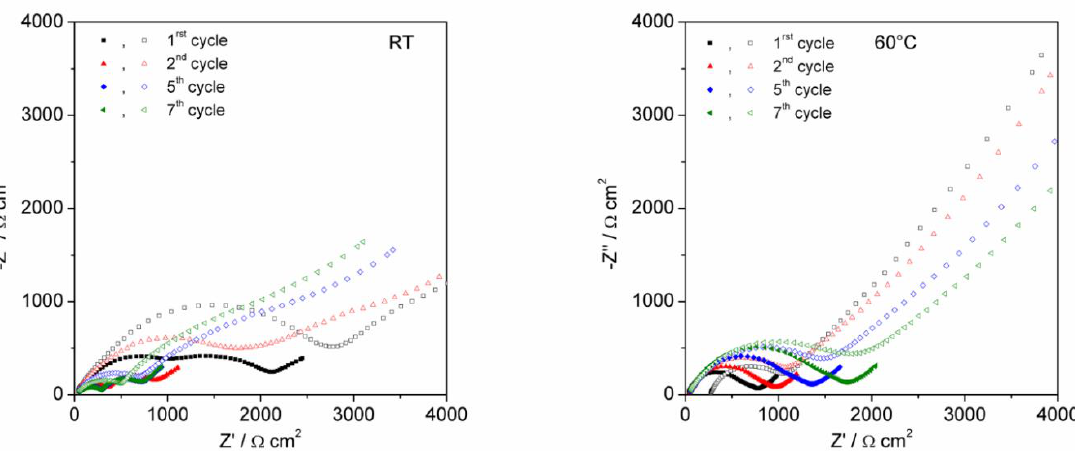
Figure 10. EIS of LMNTO at room temperature and 60 °C. Filled signs marked EOC, empty marked EOD.